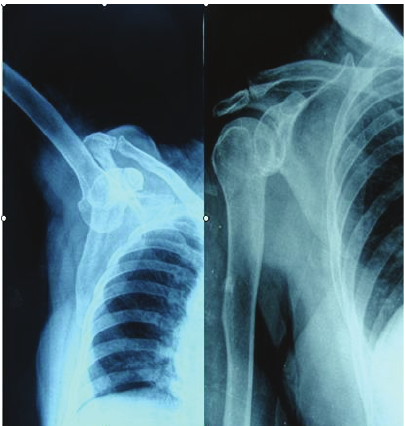
Figure 1: Two consecutive patients, reduction of the previous and next X-rays.